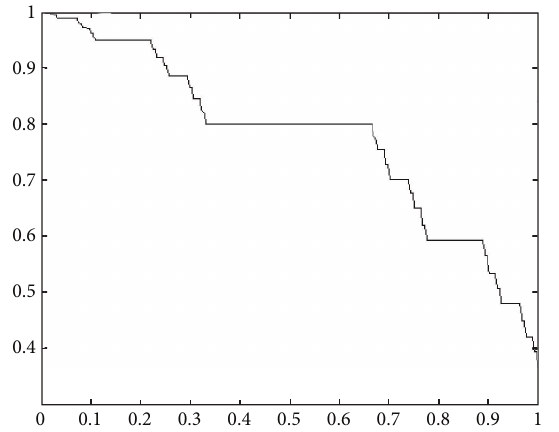
Figure 4: Graph of cos 𝛼 𝑥 𝛼 for 𝛼 = ln 2/ ln 3 .